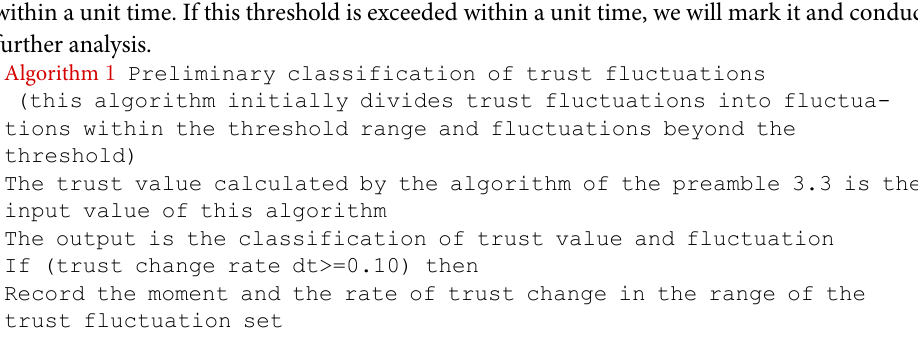
Algorithm 1 Preliminary classification of trust fluctuations